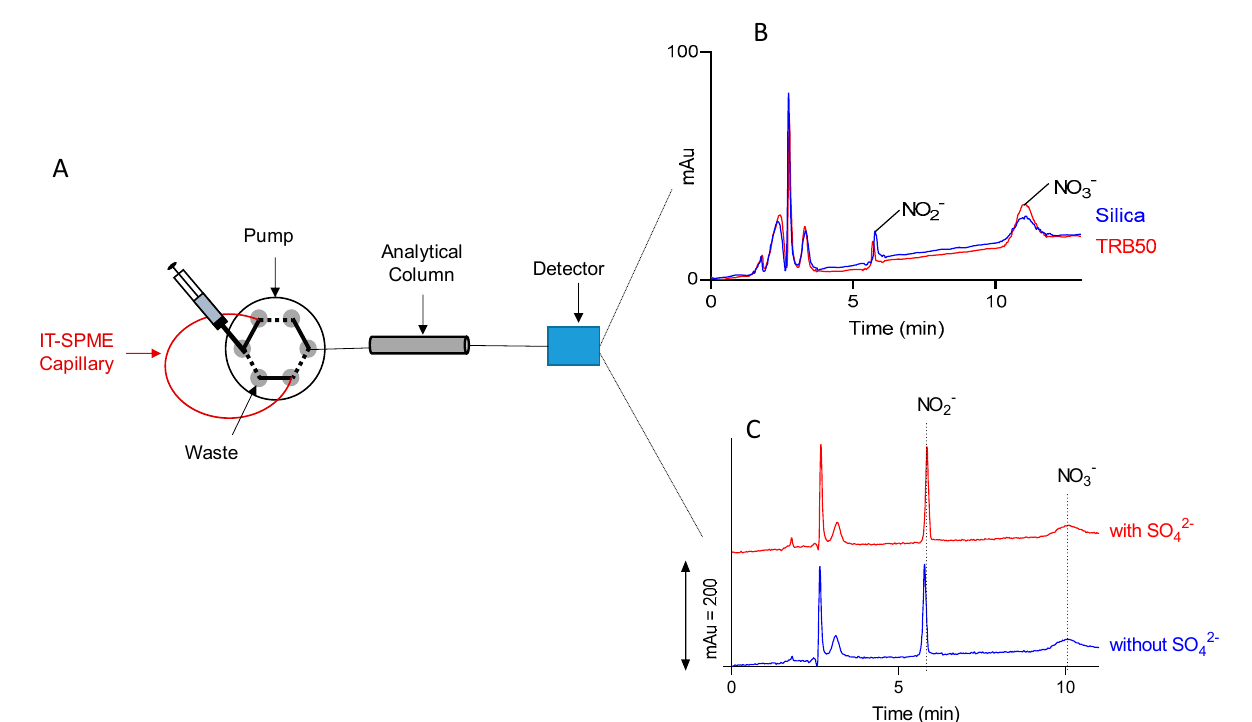
Figure 2. ( A ) Scheme of the IT-SPME-CapLC-DAD. ( B ) Influence of the nature of IT-SPME capillary: silica vs. TRB 50 for nitrate concentrations of 0.1 and 0.5 mg/L, respectively. ( C ) Chromatograms obtained by IE-CapLC for mixtures of standard solutions containing 0.5 mg/L of nitrite and 0.1 mg/L of nitrate and 0.5 mg/L of nitrite, 0.1 mg/L of nitrate and 0.5 mg/L of sulfate. The retention times for nitrite and nitrate are 5.8 and 10.5 min, respectively.